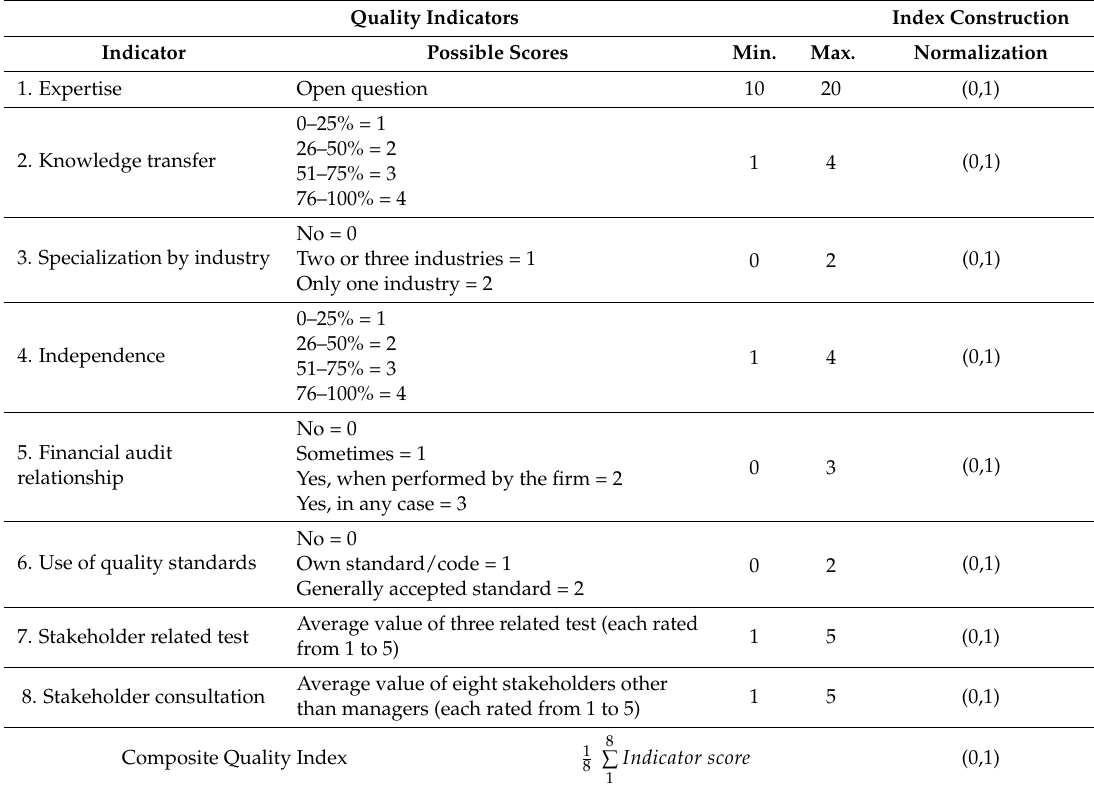
Table 3. Assurance quality